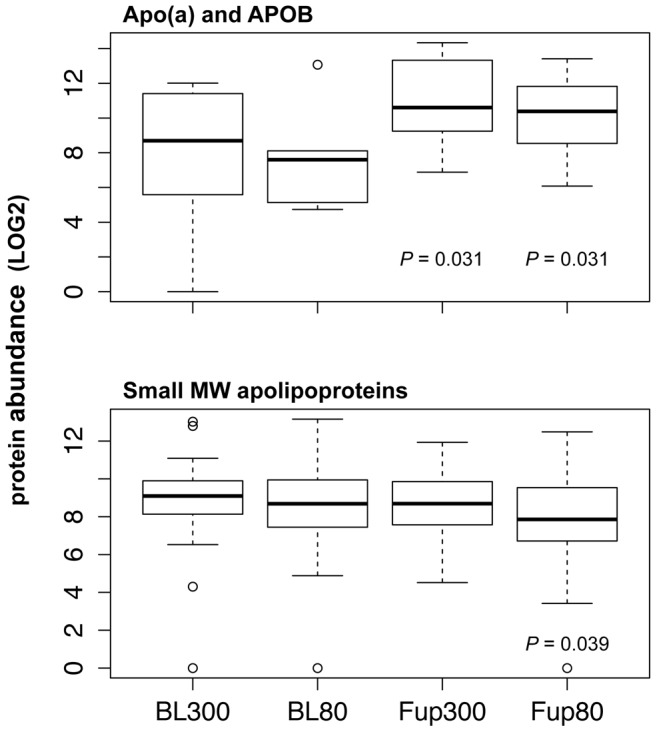
ECP therapy increases associations of Apo(a) and APOB to MPs.The sum of Apo(a) and APOB (top panel) was increased after low and high inflation pressure treatment of CAD patients. Small molecular weight apolipoproteins (APOA1, APOA2, APOA4, APOC1, APOC2, APOC3, APOD, APOE, and APOL1) were not changed or slightly decreased (bottom panel) in case of 80 mmHg inflation pressure treatment (P = 0.039), respectively.